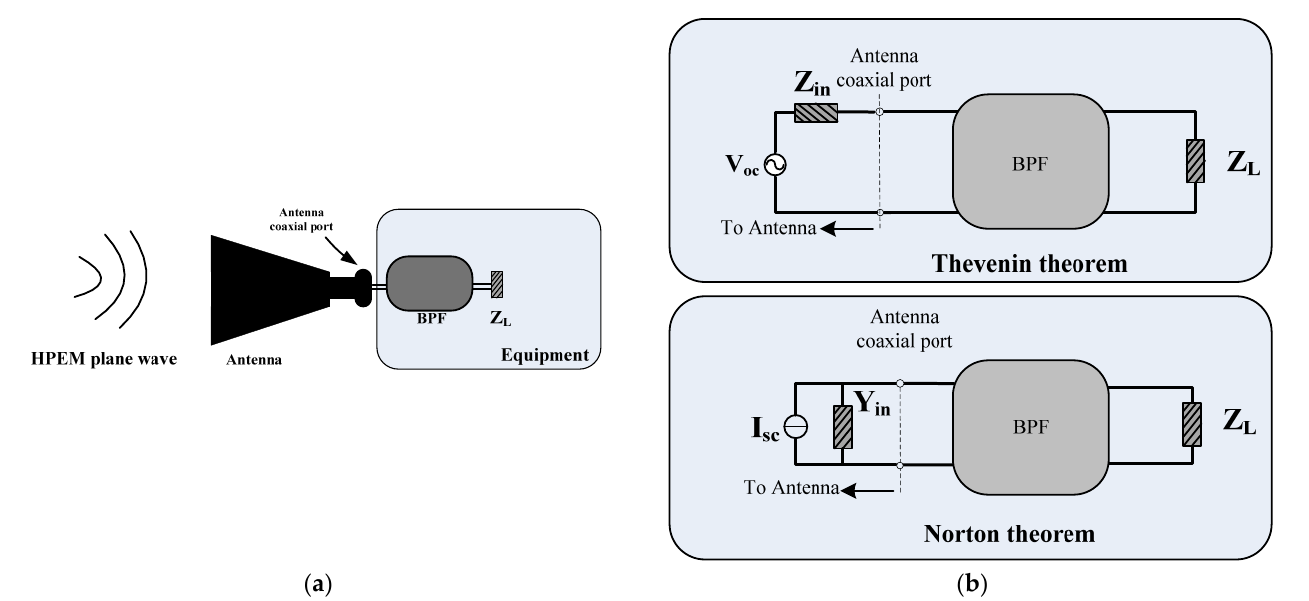
Figure 6. Equivalent circuit model of antenna response: ( a ) Antenna illuminated by HPEM; ( b ) Equivalent circuits for antenna response.